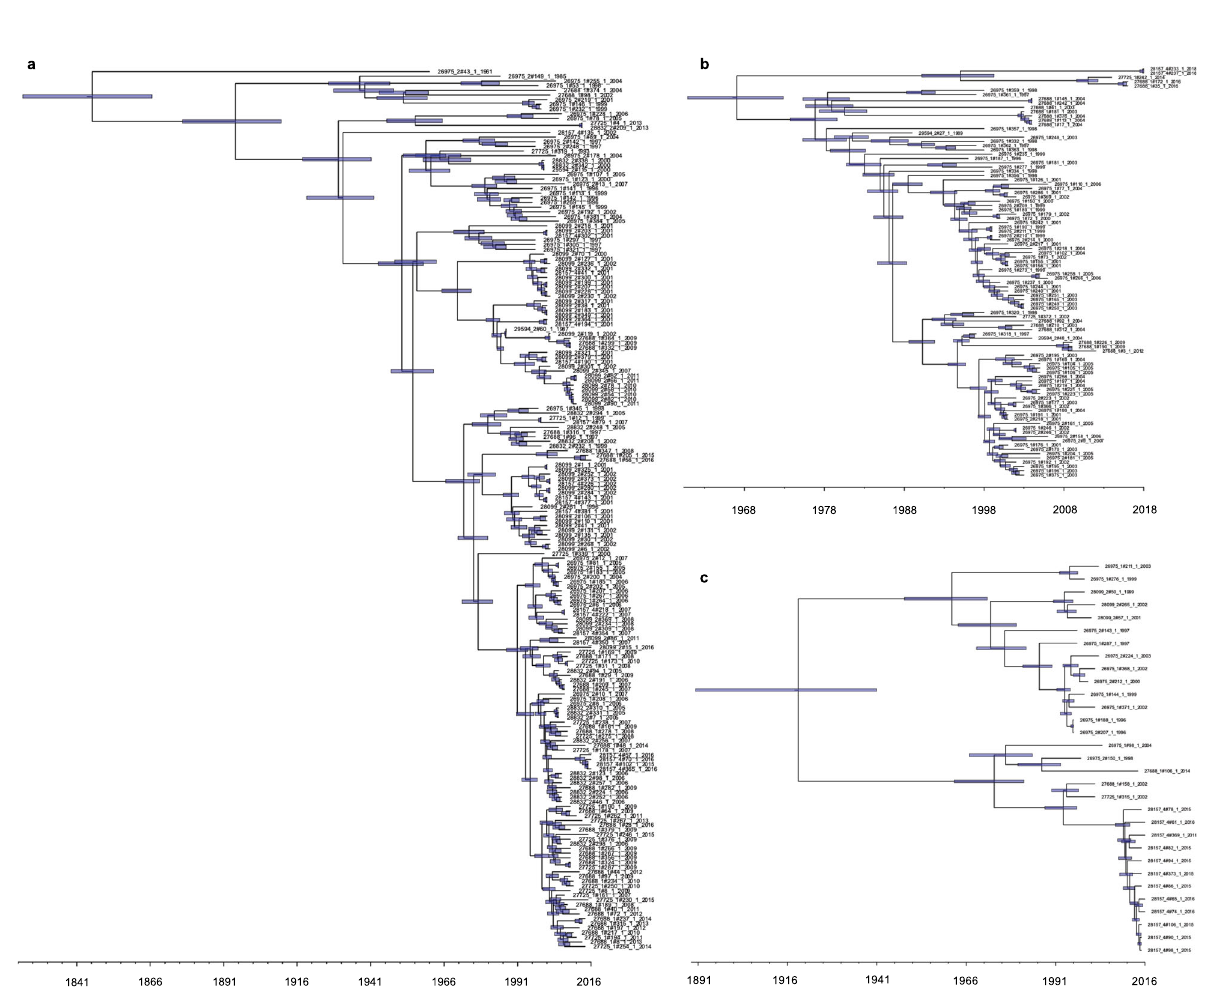
Fig. 5 Molecular clock dating reveals early and repeated emergence of extant hospital-associated (HA) E. faecalis Population Partitioning Using Nucleotide K-mers (PopPUNK; PP) 19 clusters. a PP2 ( n = 189). b PP6 ( n = 97). c PP18 ( n = 31). Dated maximum clade credibility trees were estimated based on median values from Bayesian Evolutionary Analysis by Sampling Trees (BEAST2) v.2.5.0 83 – 85 using strict clock model and constant tree. Blue error bars represent the 95% highest probability density (HPD) intervals of median tree heights. The time scale is shown in years. Source data are provided as a Source Data fi